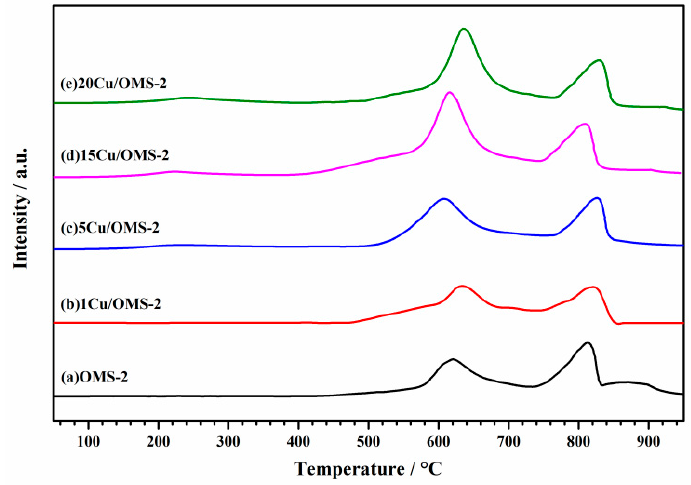
Figure 6. O 2 -TPD profiles of ( a ) OMS-2, ( b ) 1Cu/OMS-2, ( c ) 5Cu/OMS-2, ( d ) 15Cu/OMS-2, and ( e ) 20Cu/OMS-2.